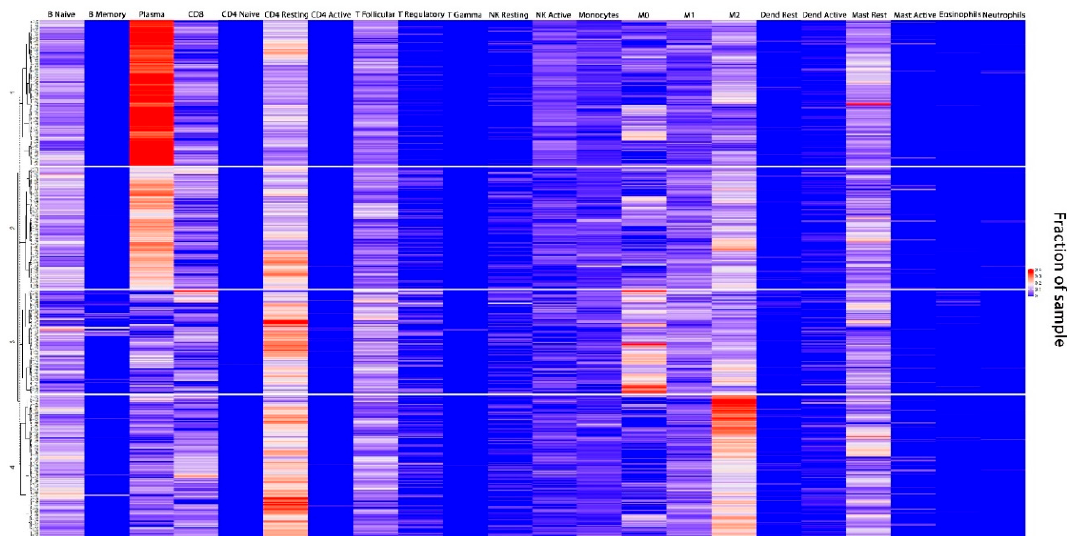
Figure A1. Supplemental heatmap displaying all clustering data for gene signatures in the TCGA PRAD dataset. Due to the unsupervised nature of the clustering the order of clusters 1 and 2 are interchanged from Figure 1, as is much of the intra-cluster ordering. However, the unique identifiers in each cluster remain the same (rows of the heatmap). Abbreviations: CD8, CD8 + T cells; CD4, CD4 + T cells; T gamma, T cells gamma delta; NK, natural killer cells; Dend Rest, resting dendritic cells; Dend Active, activated dendritic cells; Mast Rest, resting mast cells; Mast Active, activated mast cells. Table A1. Pairwise t-tests comparing each cluster in the TCGA PRAD cohort, divided by cell type. M2 Macrophages M0 Macrophages Cluster